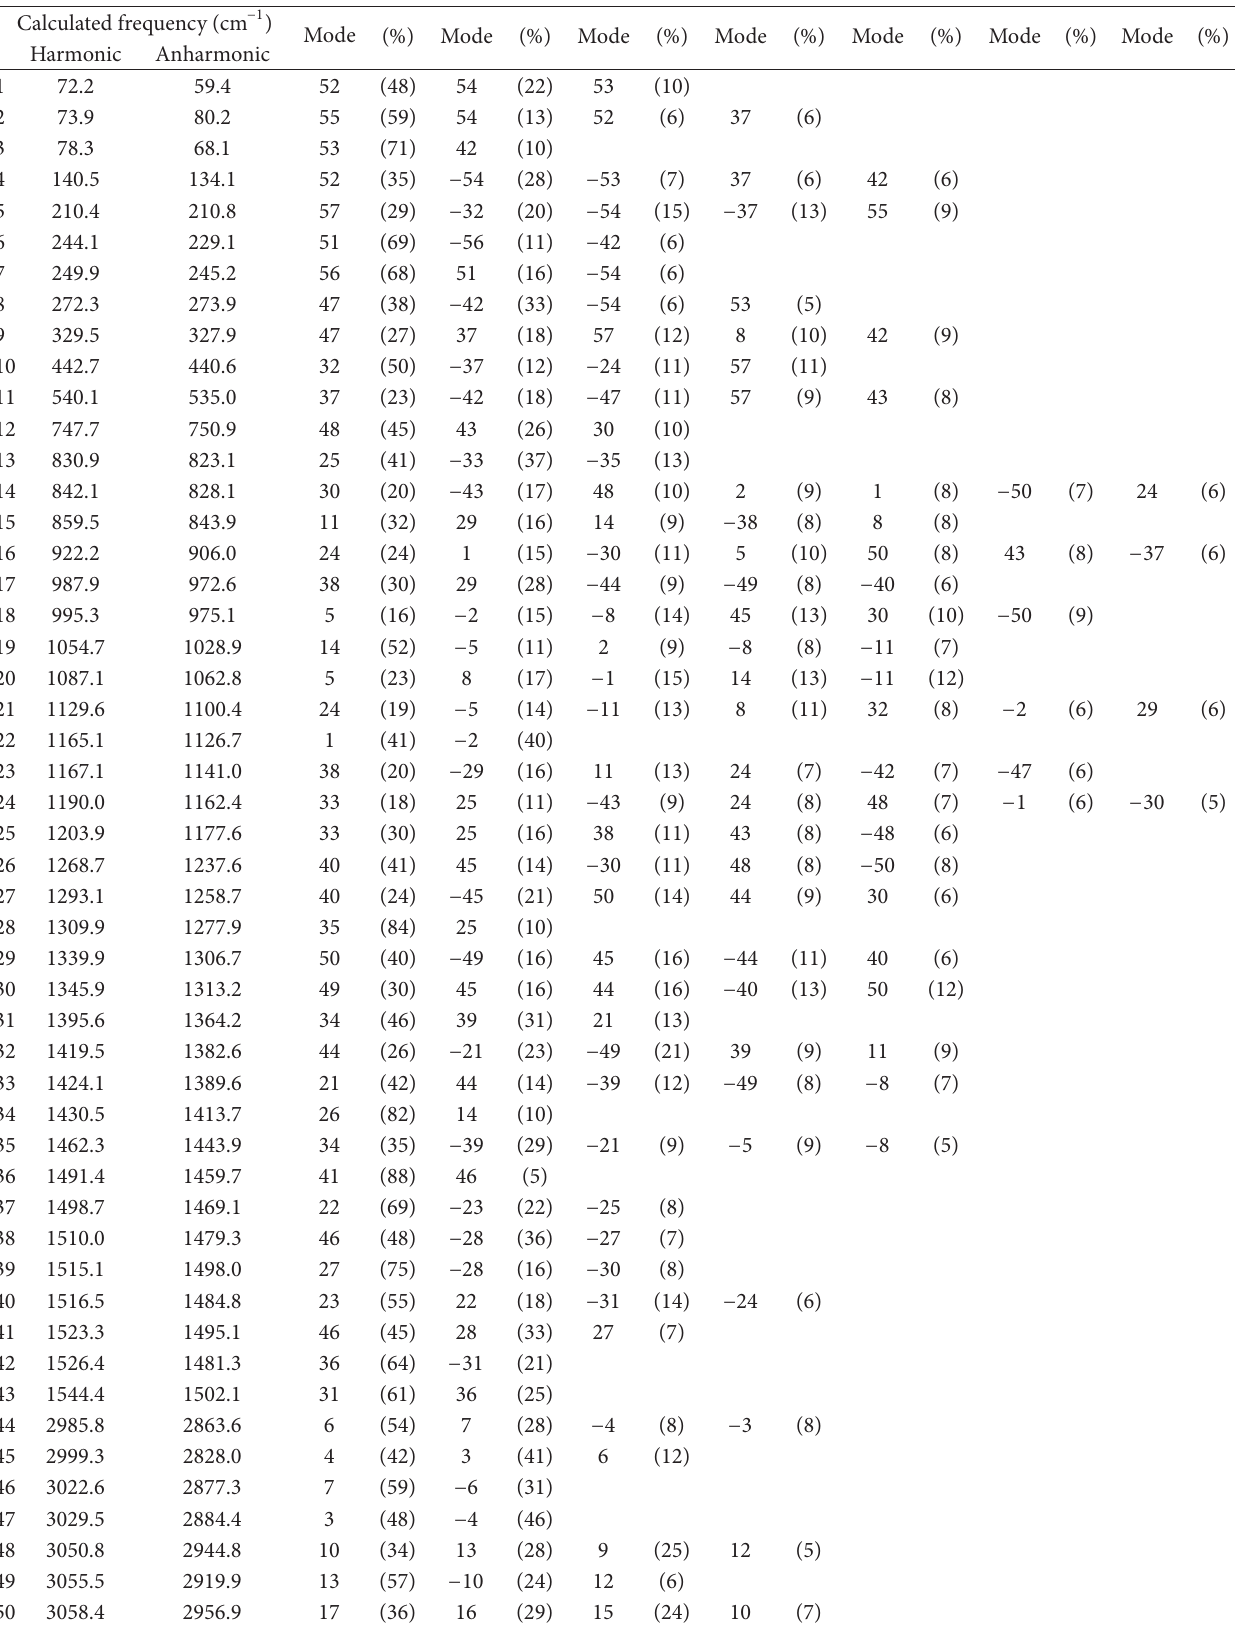
T 3: PED table for the major conformer (“TG